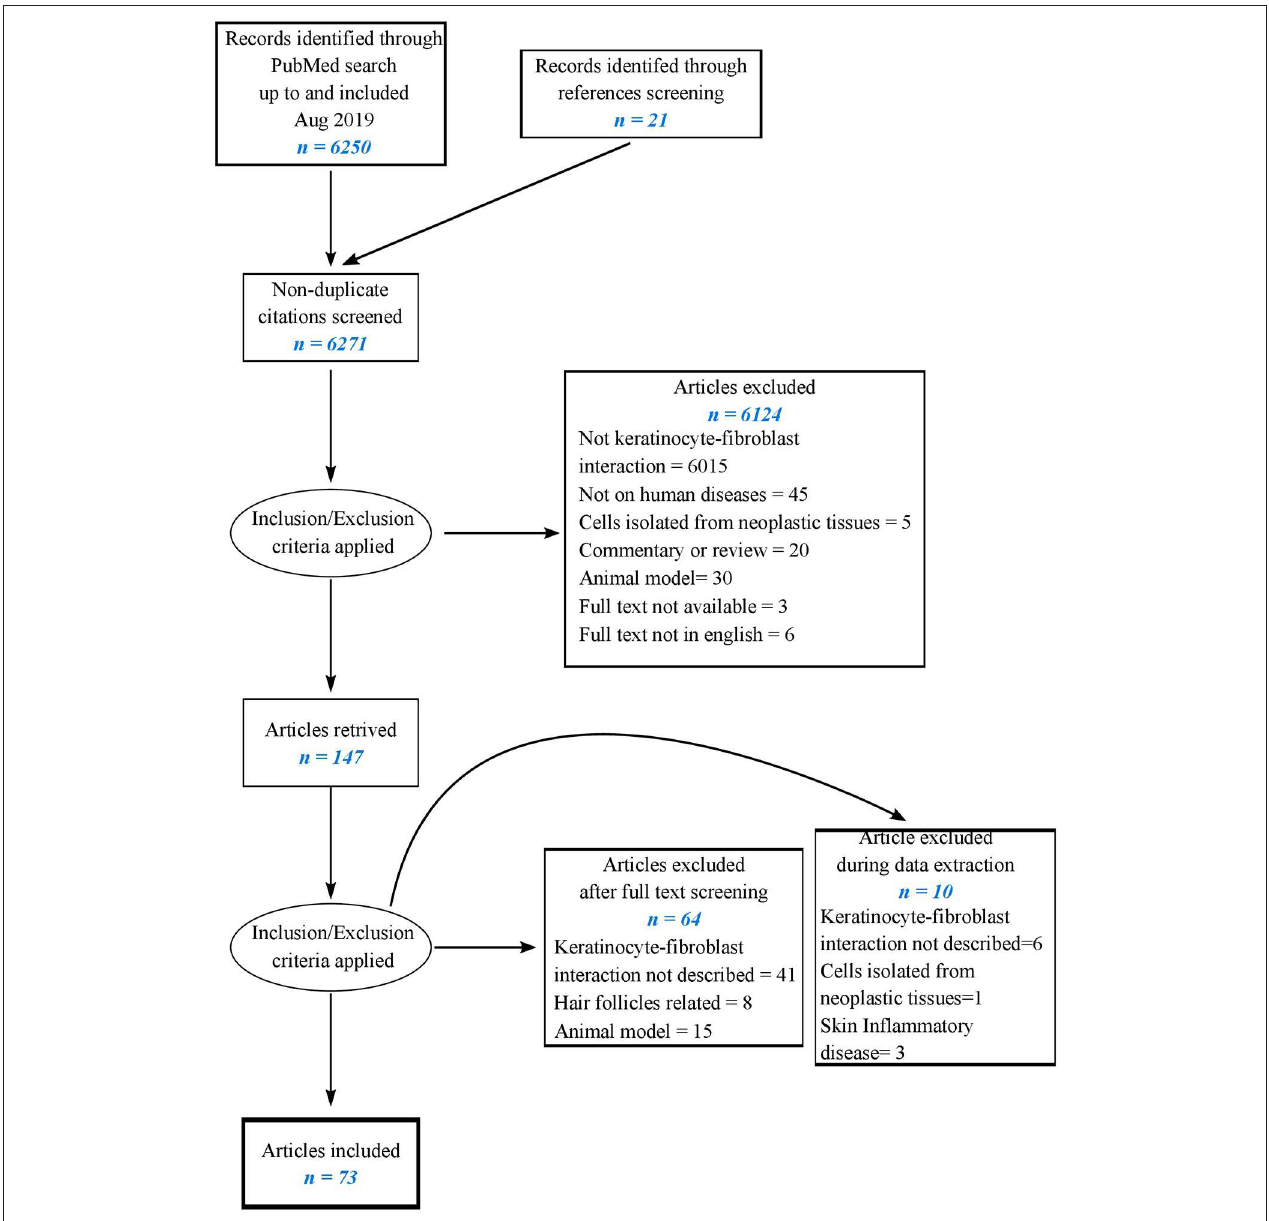
FIGURE 1 | Flow chart of the literature-searching strategy.